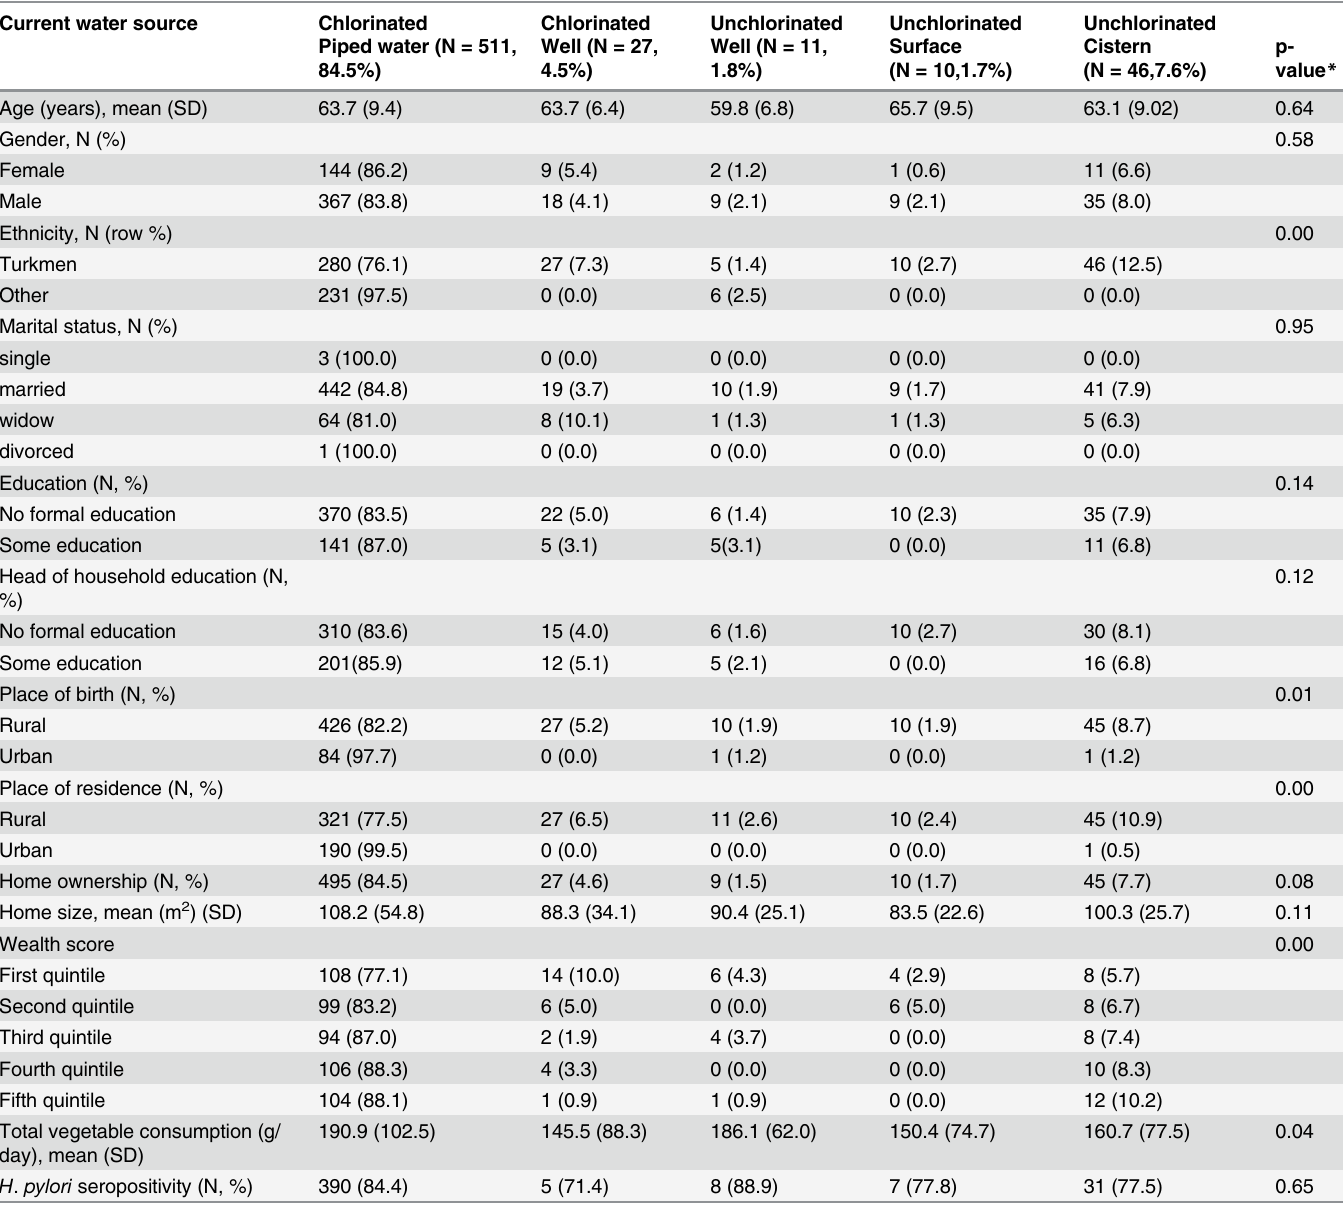
Table 3. Factors associated with drinking water source among controls in the Golestan Gastric Cancer Case-Control